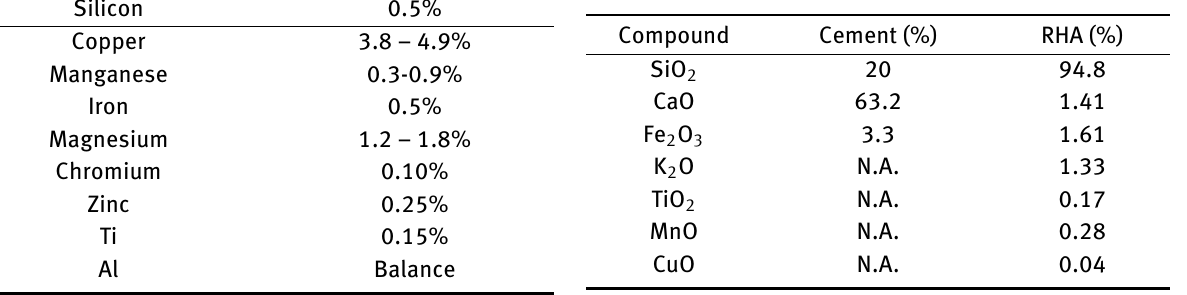
Table 1: Chemical Composition of AA2024 alloy [13]